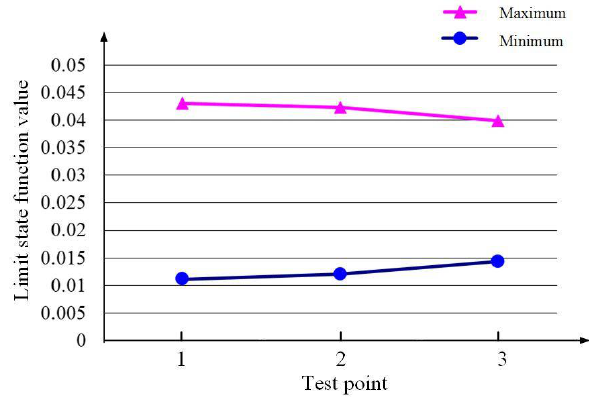
Figure 7. Variation tendency of the limit-state function.